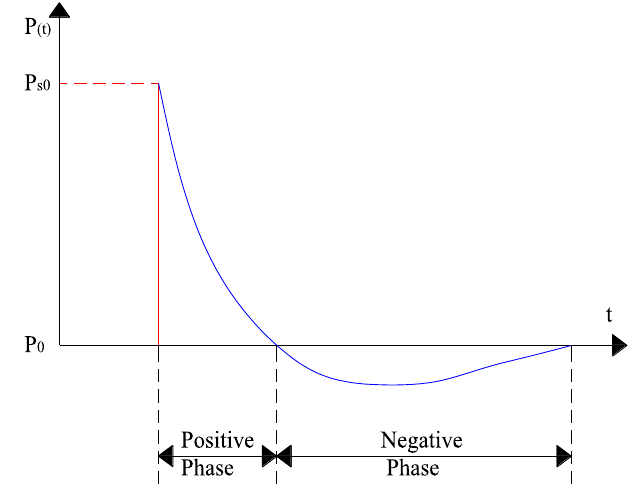
Fig. 9 Blast wave pressure‑ time history (UFC‑3‑340‑02,